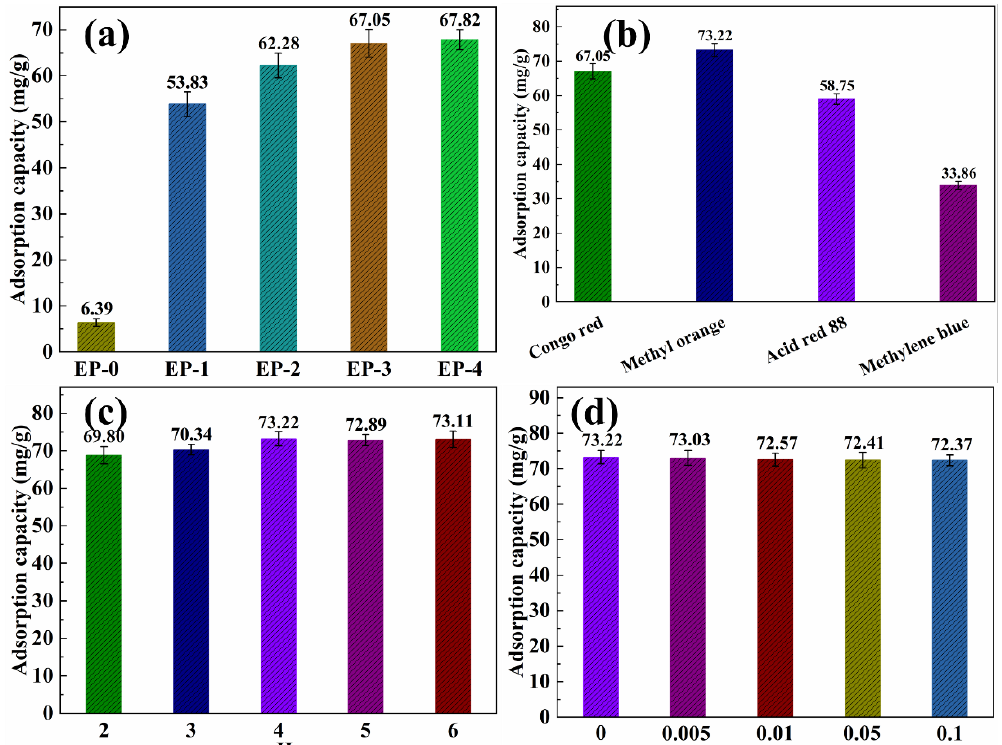
Figure 6. ( a ) Adsorption capacity of EVOH/PANI composite NFAs with various PANI nanorod contents for Congo red; ( b ) adsorption capacity of EP-3 for various dyes; ( c ) adsorption capacity of EP-3 for methyl orange under different pH values; ( d ) adsorption capacity of EP-3 for methyl orange under different ionic strengths.